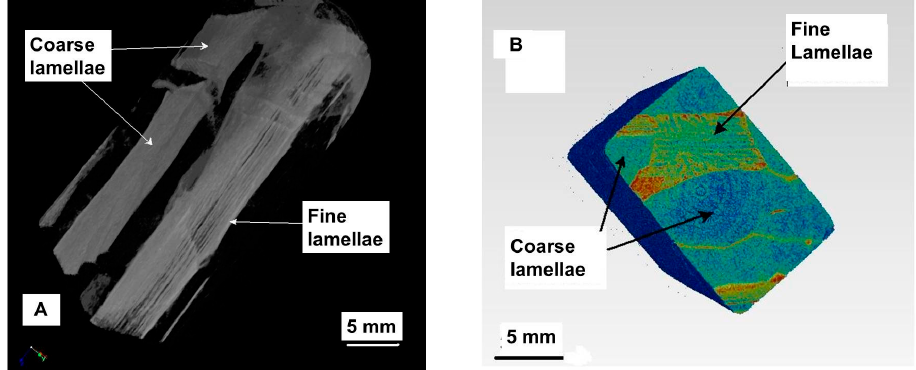
Figure 2. Volume rendered NCT image ( A ) of the Seymchan sample and ( B ) false color reconstructed axial section.